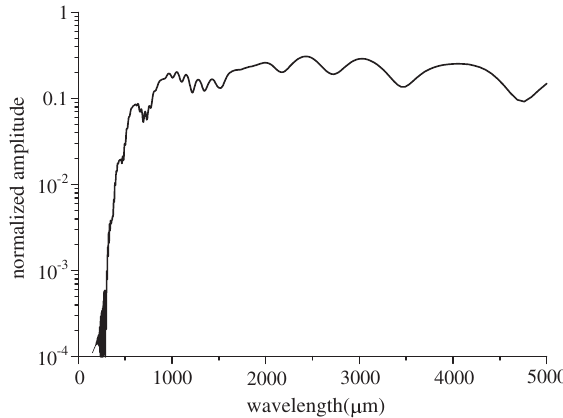
FIG. 5. Particle-in-cell simulation of the diffraction radiation from the leading and trailing edges of the blank